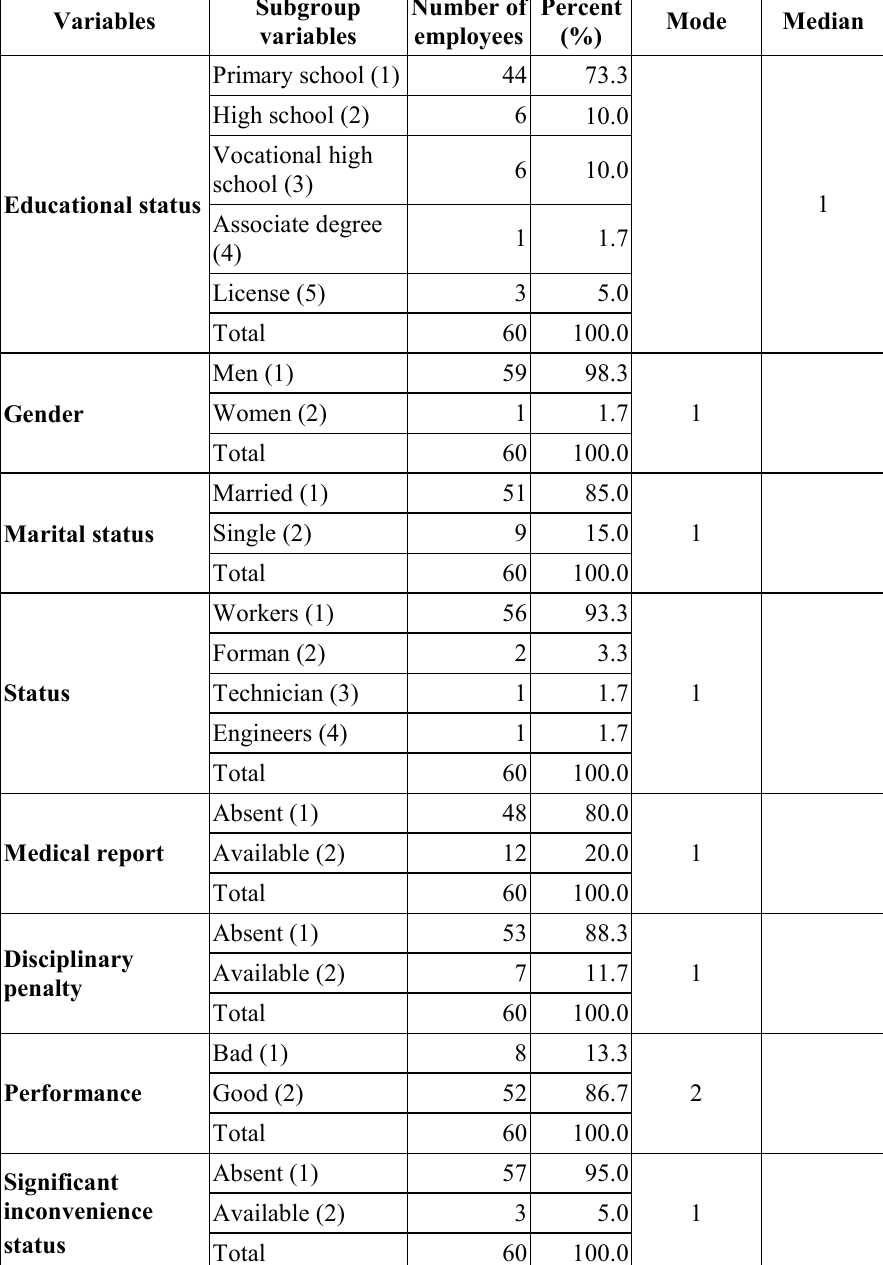
Table 1. Descriptive Statistics for